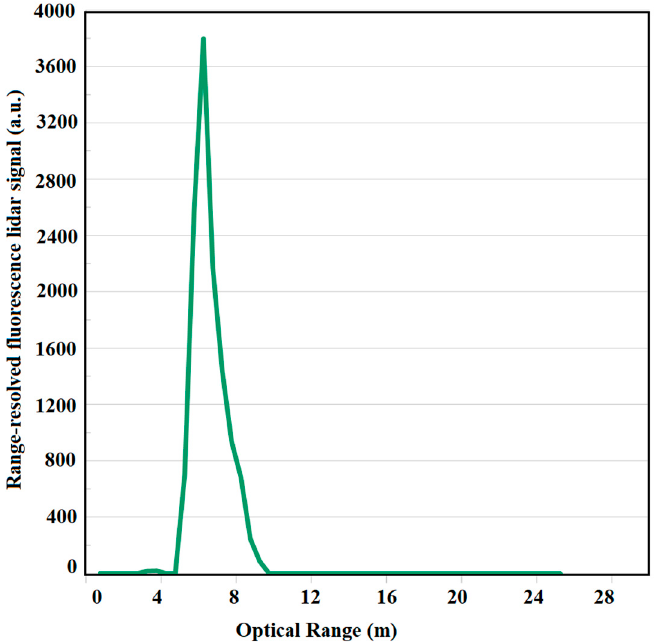
Figure 6. Range-resolved profile at 20 mg/L Spirulina concentration using the pulsed LED fluores- cence lidar system at an excitation wavelength of 385 nm and an emission wavelength at 680 nm. The lidar profile of 20 mg/L is the same for other concentrations used in this study.